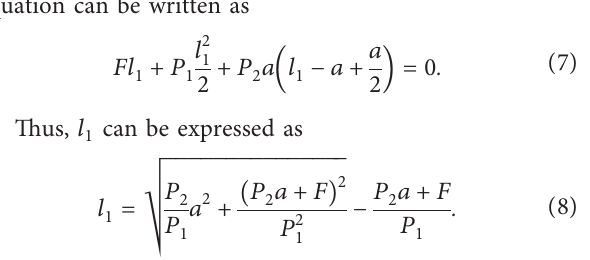
Figure 2: The mechanics model of forward direction fault (the initial